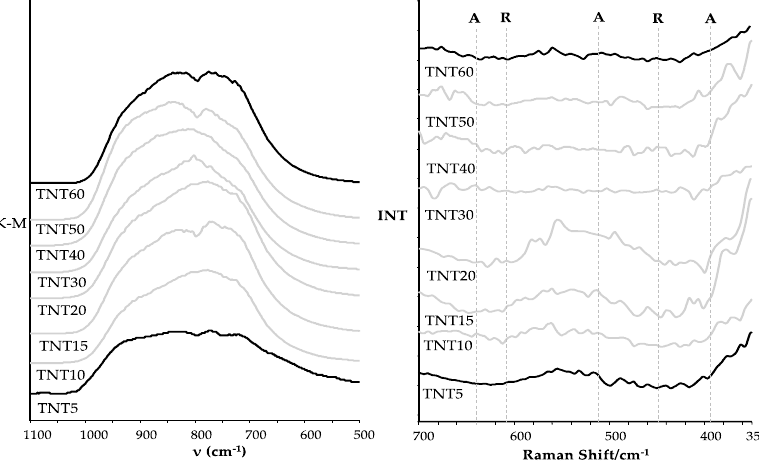
Figure 2. Infrared diffuse reflectance Fourier transform spectroscopy (IR DRIFT) and Raman spectra of TNTs.